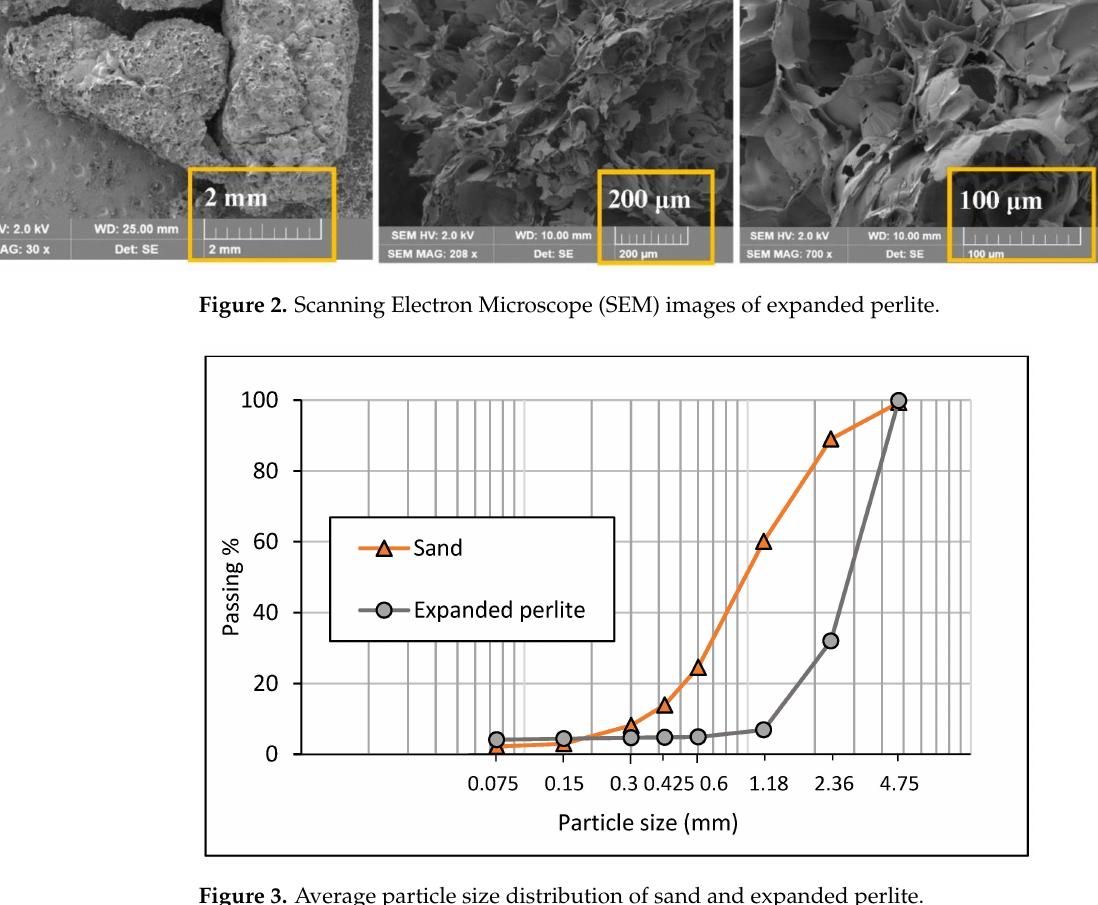
Figure 3. Average particle size distribution of sand and expanded perlite.